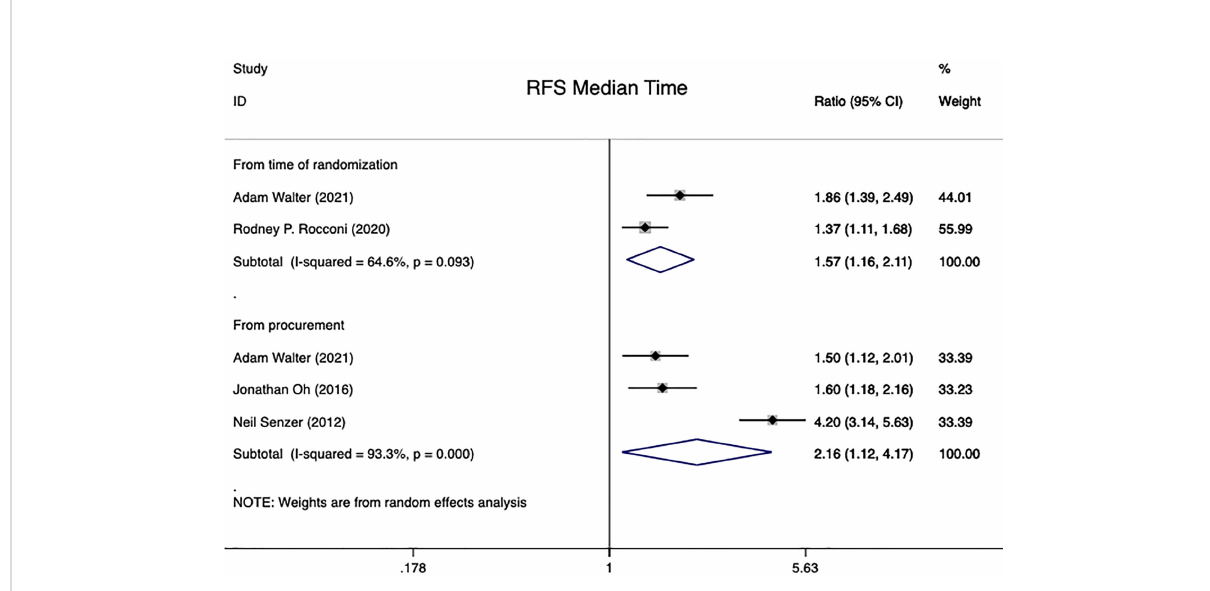
FIGURE 4 RFS median time in advanced OC patients at randomization and from time of tissue procurement time by using a random-effect model. OC, ovarian carcinoma; CI, con fi dence interval; HR, hazard ratio; RFS, recurrence free